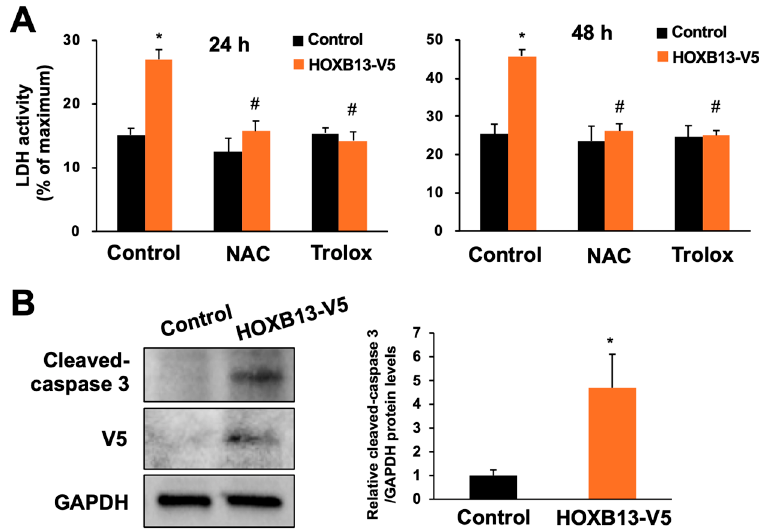
Figure 4. Effects of overexpression of HOXB13 on cell viability. A549 cells were transfected with control plasmid or HOXB13-V5-expressing plasmid for 24 h and then the cells were re-seeded onto 48-well plates. ( A ) After the re-seeding and culture for 24 h (left panel) or 48 h (right panel) with or without NAC (100 µM) or Trolox (10 µM), cell death was measured by LDH assay. ( B ) After the re-seeding and culture for 24 h, immunoblots for cleaved-caspase 3, V5-tag, and GAPDH were performed (left panel). Right panel indicates densitometry analysis of the band intensity in the left immunoblot. All values are mean ± S.D. of three individual experiments. * p < 0.05 vs. control, # p < 0.05 vs. control group that was transfected with the HOXB13-V5-expressing plasmid.